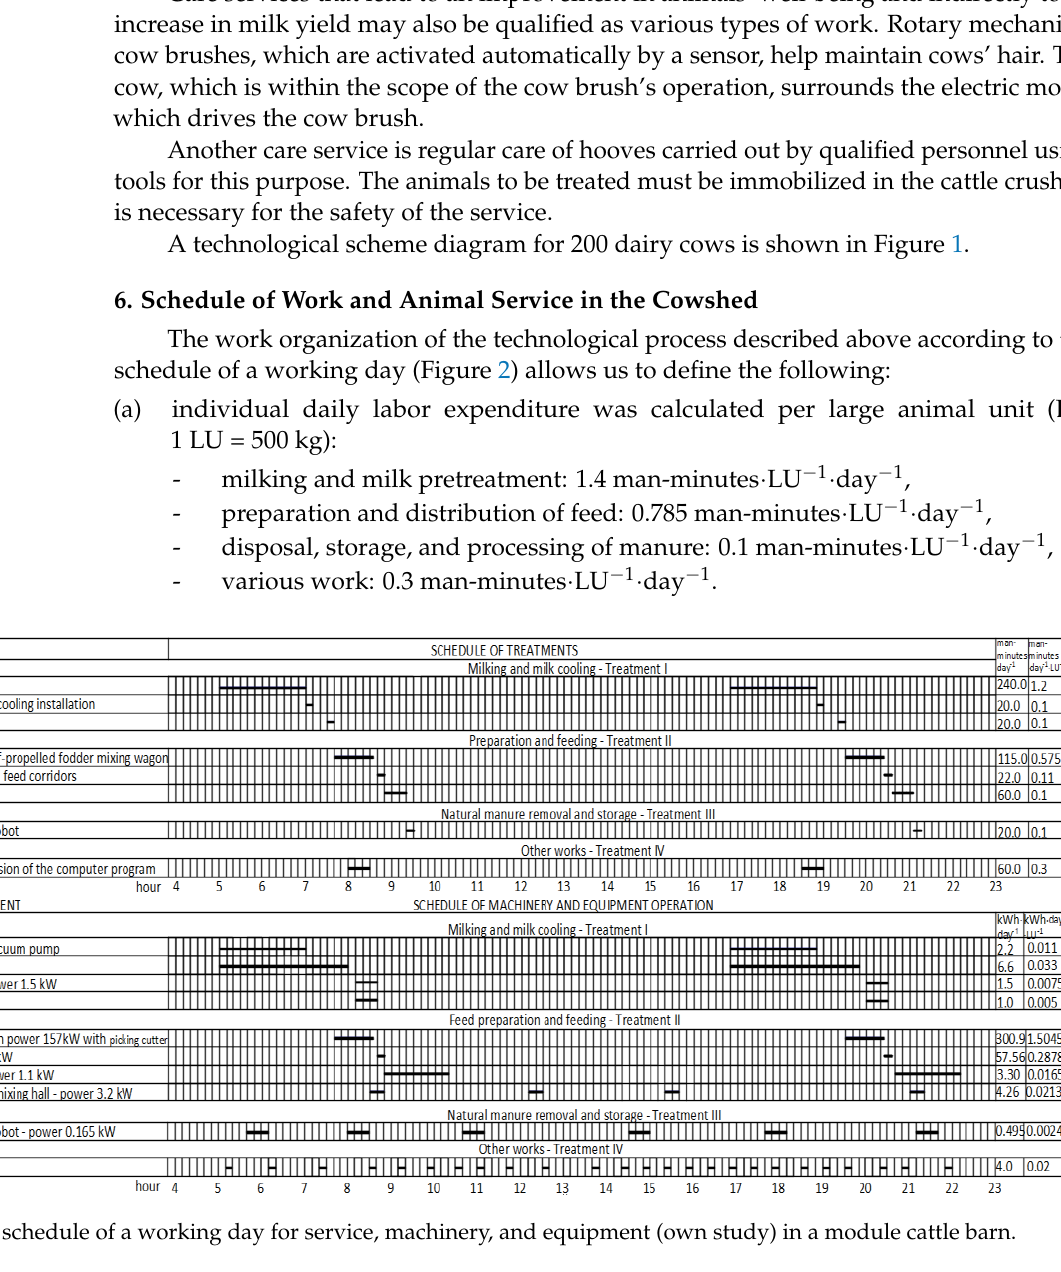
Figure 3. Percentage of labor inputs in the module cattle barn. 7. Innovative Management of Natural Fertilizers in a Module Cowshed Because of the considerable amount of organic fertilizer — about 10,000 kg of slurry per day — the problem of proper management is particularly important. The typical amount of produced slurry from an average cow is 50 kg. The proposed procedure for liquid manure involves the following: - separation; -